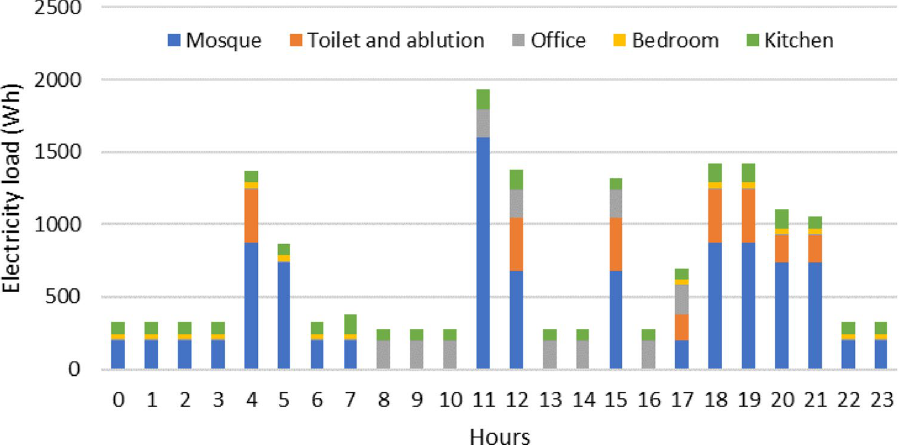
Figure 3. The hourly load demand profile of Ontowiryo Mosque.